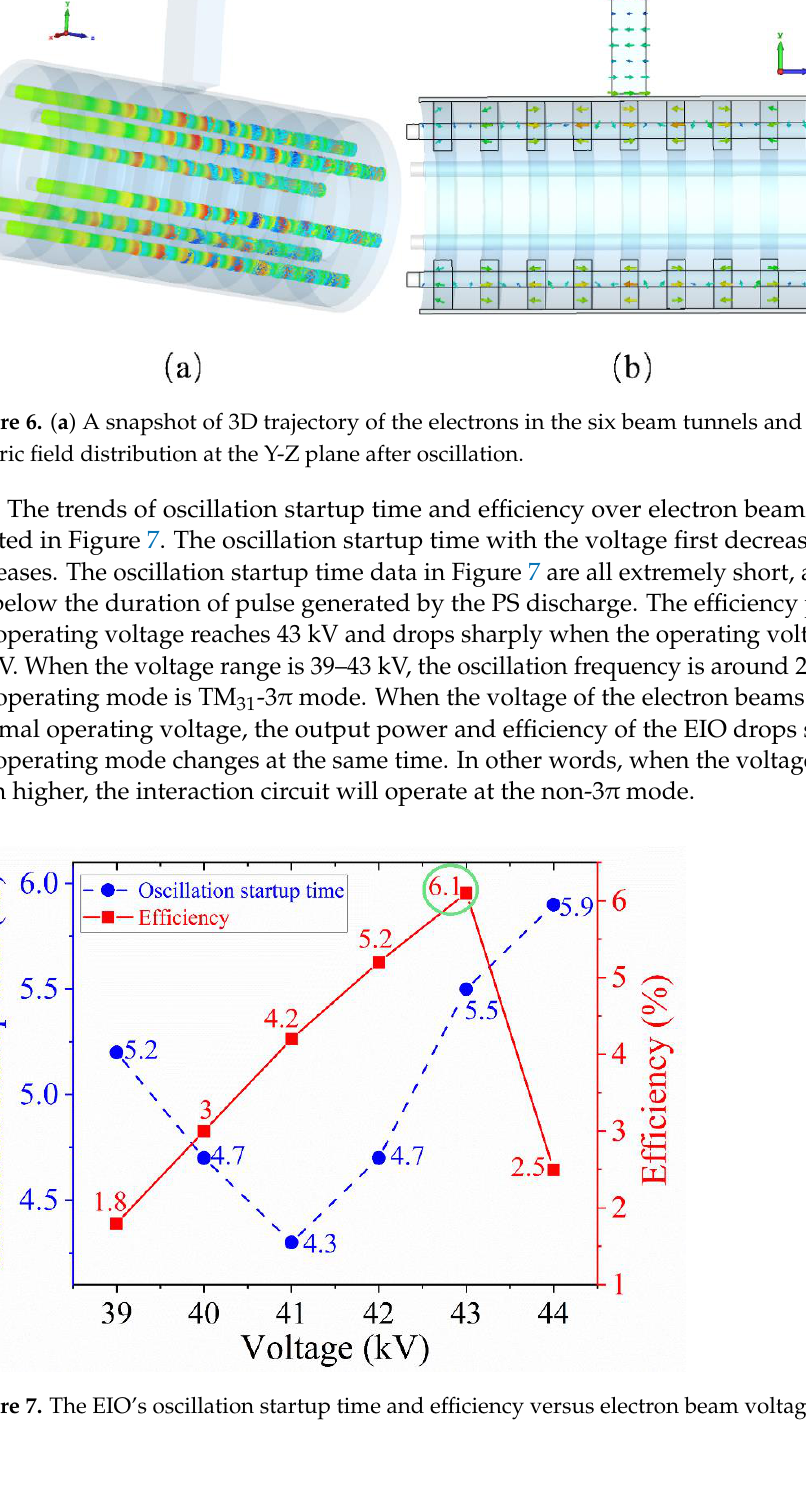
Figure 5. Time-dependent output power and frequency spectrum of CST Particle Studio simulation results.